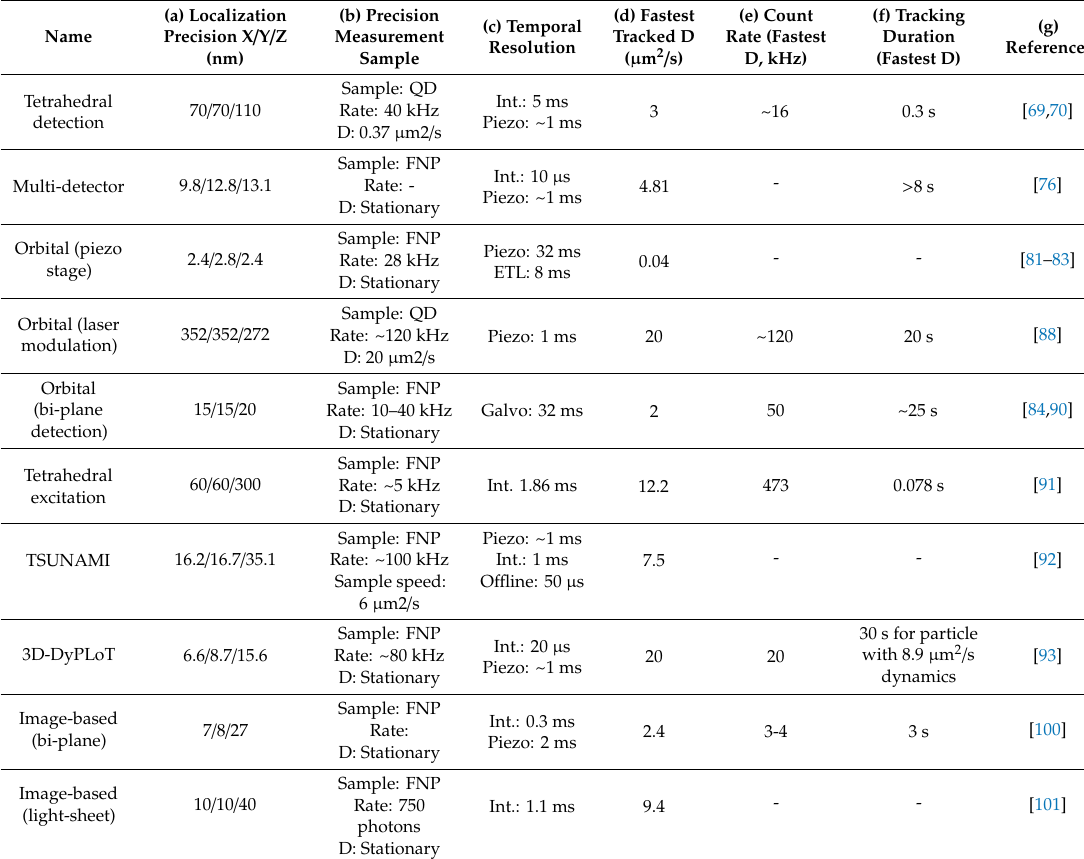
Table 1. Comparison of active feedback RT-3D-SPT methods. (a) Localization precision measurement for each method. (b) Sample and conditions used for the localization precision measurement in